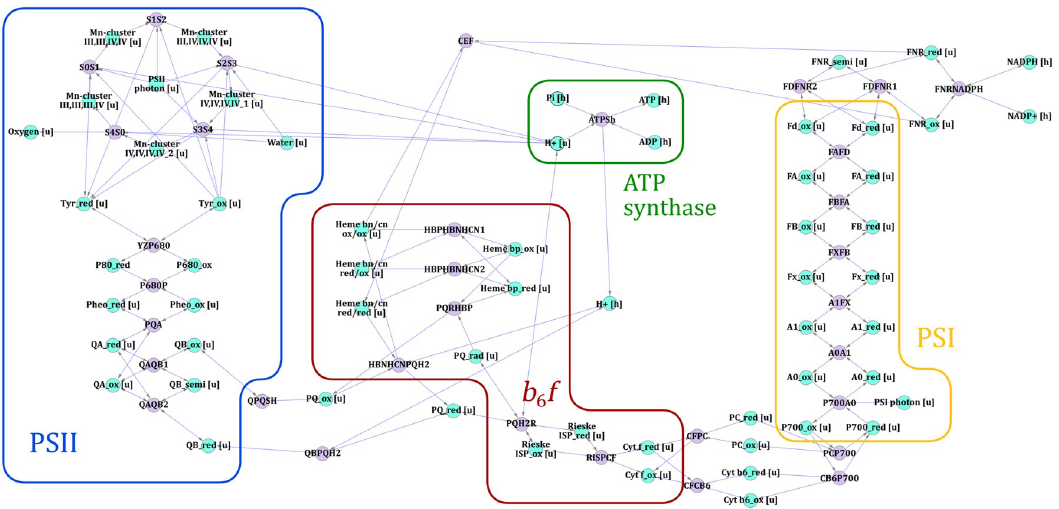
Fig 2. Representation of photosynthesis in the chloroplast model. The areas marked PSII, b 6 f , PSI and ATP synthase shows where in the photosynthetic electron transport chain the different electron transfers and reactions are taking place. Light blue nodes represent metabolites, while purple nodes represent